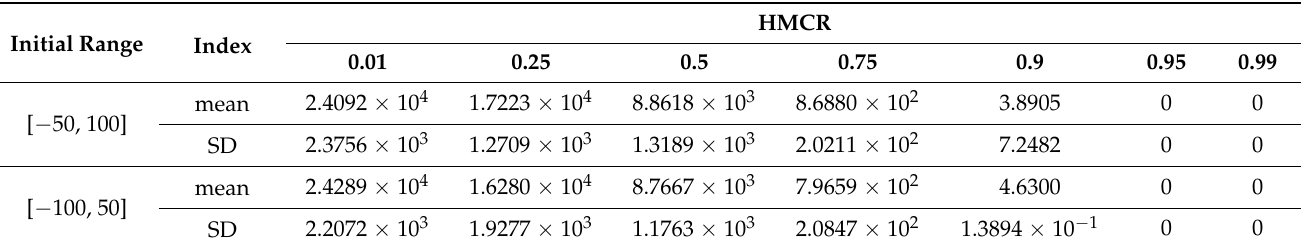
Table 2. Numerical results with different HMCR values for